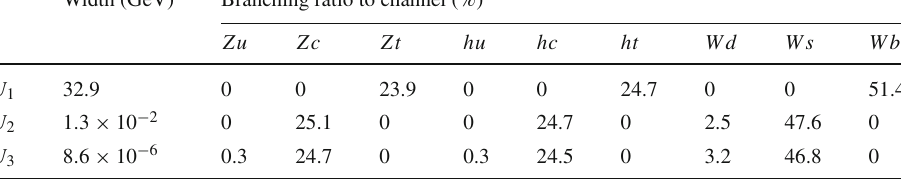
Table 4 Decays of new up-type